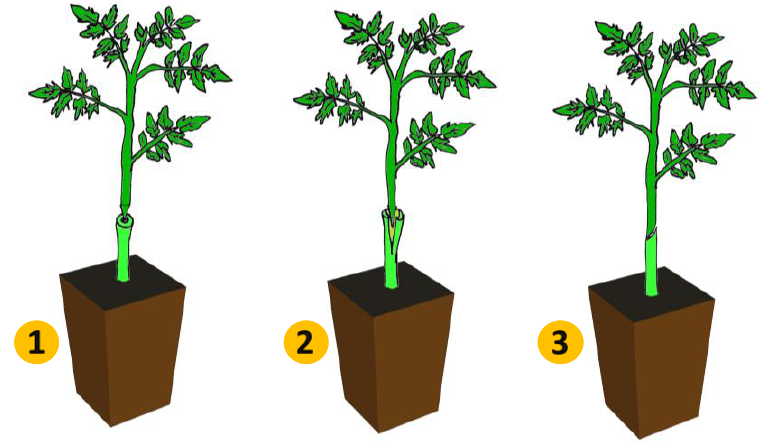
Figure 1. Common grafting methods to join scion and rootstock for solanaceae. Highlights the use of splice grafting technique. It is widely used as it is efficient and easy to execute. ① Hole grafting, ② cleft grafting, ③ splice